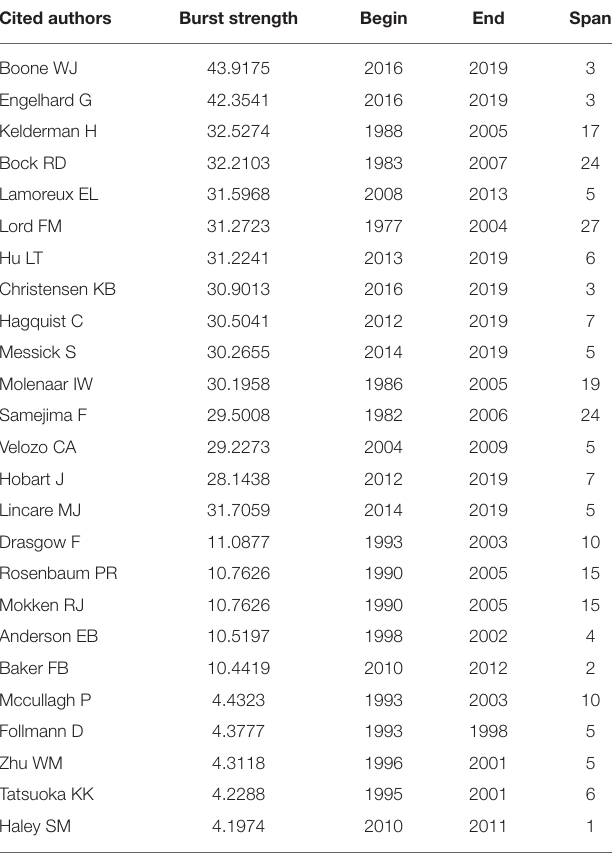
TABLE 1 | Sample author bursts computed via author co-citation analysis (ACA).